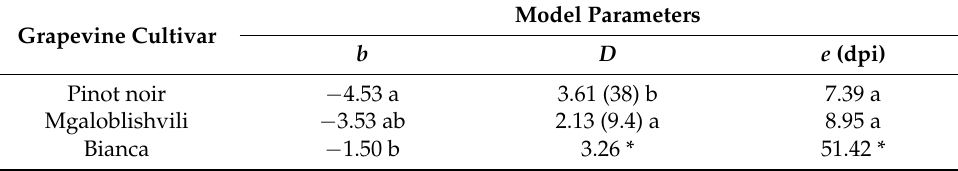
Table 2. Estimated parameters obtained for each curve (grapevine cultivar) with the log-logistic model on transformed PSA values. Different letters within columns indicate the existence of significant differences among log(x + 1) transformed b (slope) and d (upper asymptote) values and e (t 50 ) values (expressed as dpi) ( p < 0.01). Values in brackets represents back-transformed (y = e x + 1) values of d to the original scale (PSA %). Model Parameters Grapevine Cultivar b Pinot